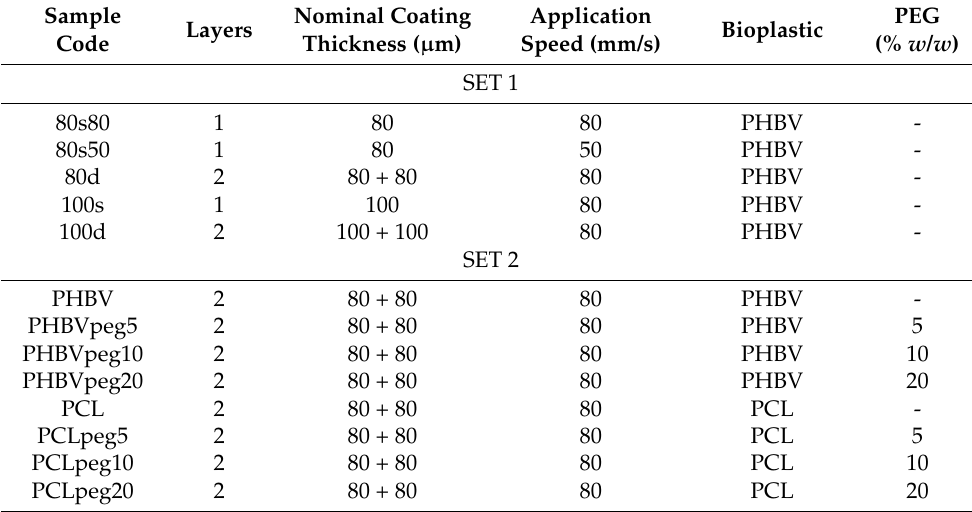
Table 1. Coating conditions and codification of samples from the first and second